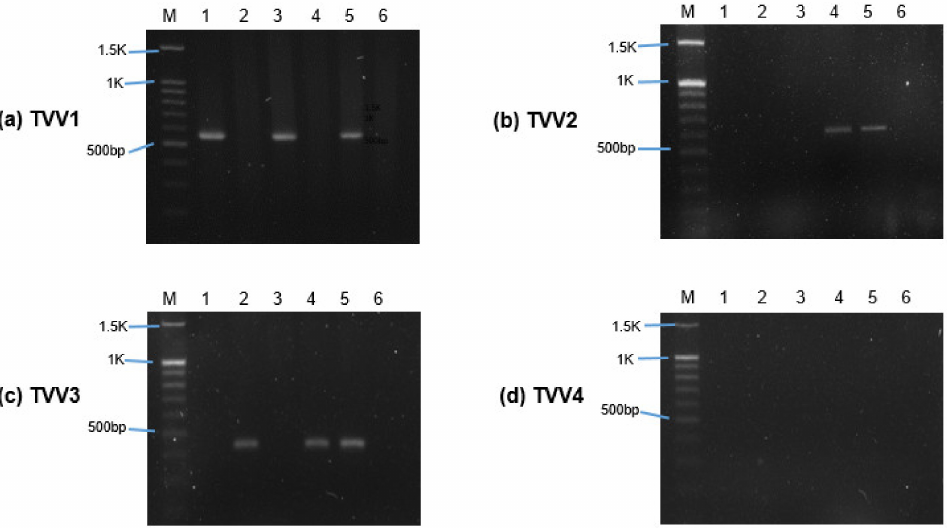
Figure 1. Detection of Trichomonasvirus (TVV) subspecies in T. vaginalis isolates using RT-PCR. ( a – d ) showed the separation of RT-PCR products amplified by TVV1, TVV2, TVV3, and TVV4 subspecies-specific primers on 1.5% agarose gel. M indicates the marker (DNA ladder). Lanes labeled 1 to 6 represent T. vaginalis isolates ATCC 30236, ATCC 30238, T1, ATCC PRA-98, ATCC 50148, and ATCC 50143.